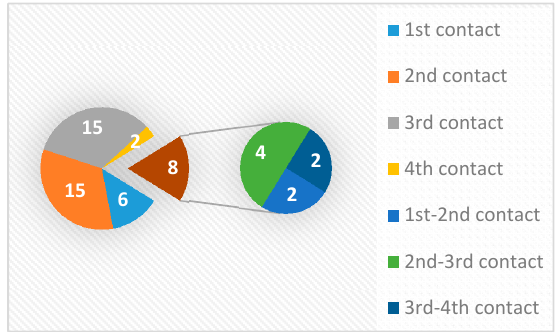
Figure 10. The distribution of the active contacts used as the final targets.